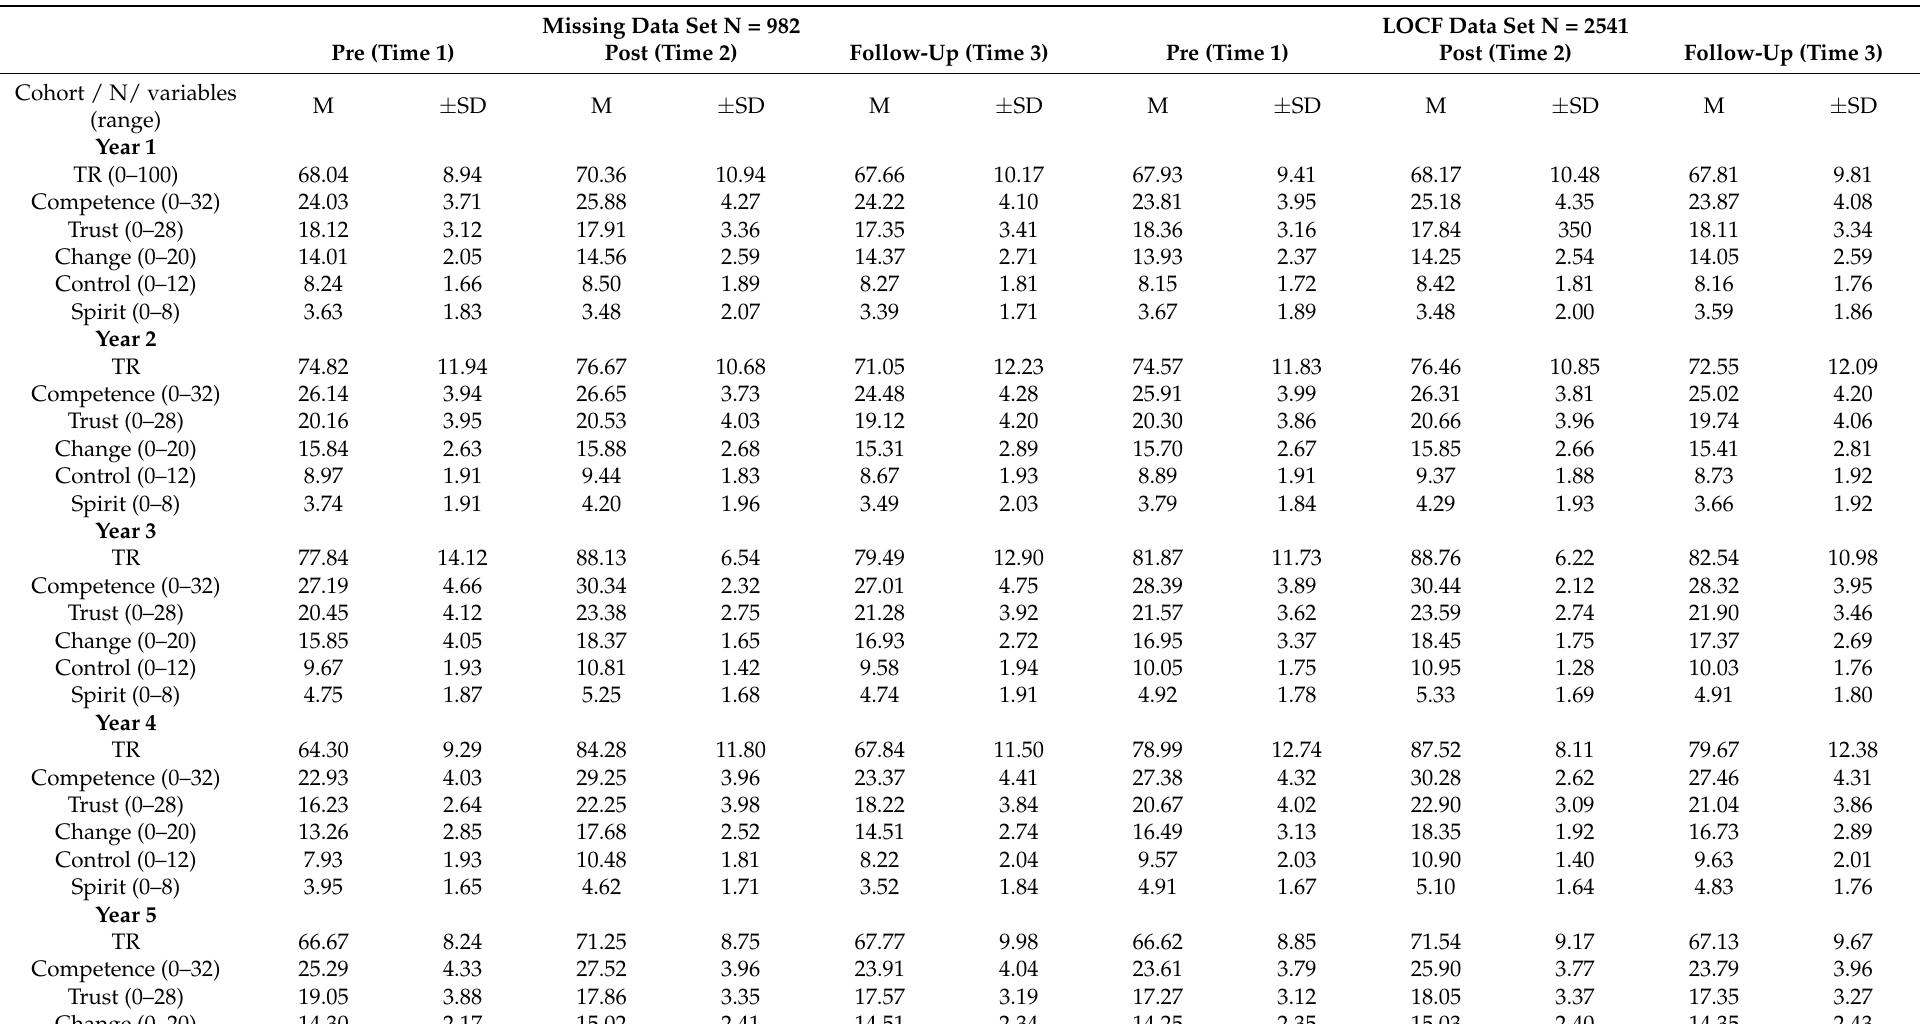
Table 2. Pre, post, and follow-up mean scores for total resilience (TR) by annual cohort for Missing Data and last observation carried forward (LOCF) data